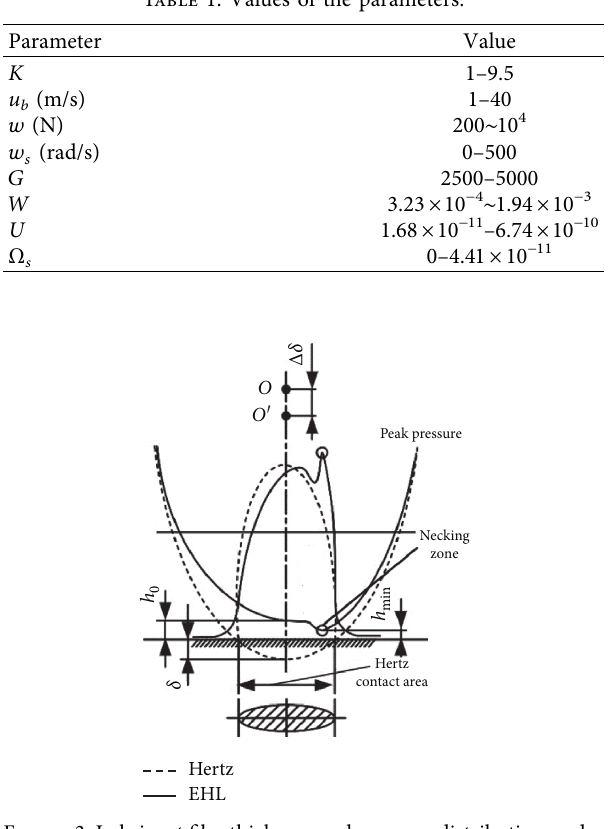
Table 1: Values of the parameters.